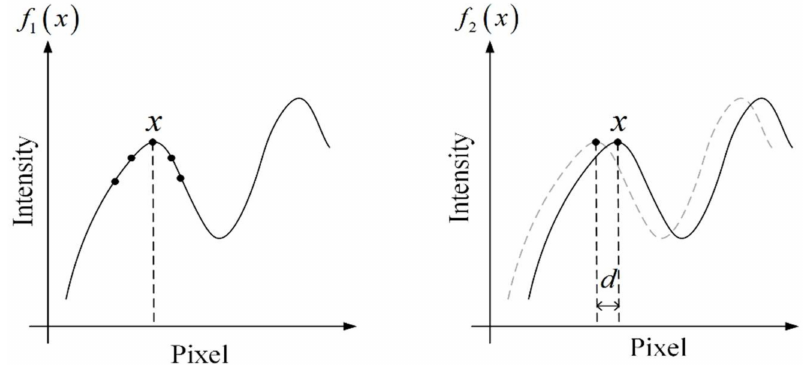
Figure 2. Local signal model of the 1D image undergoes a small